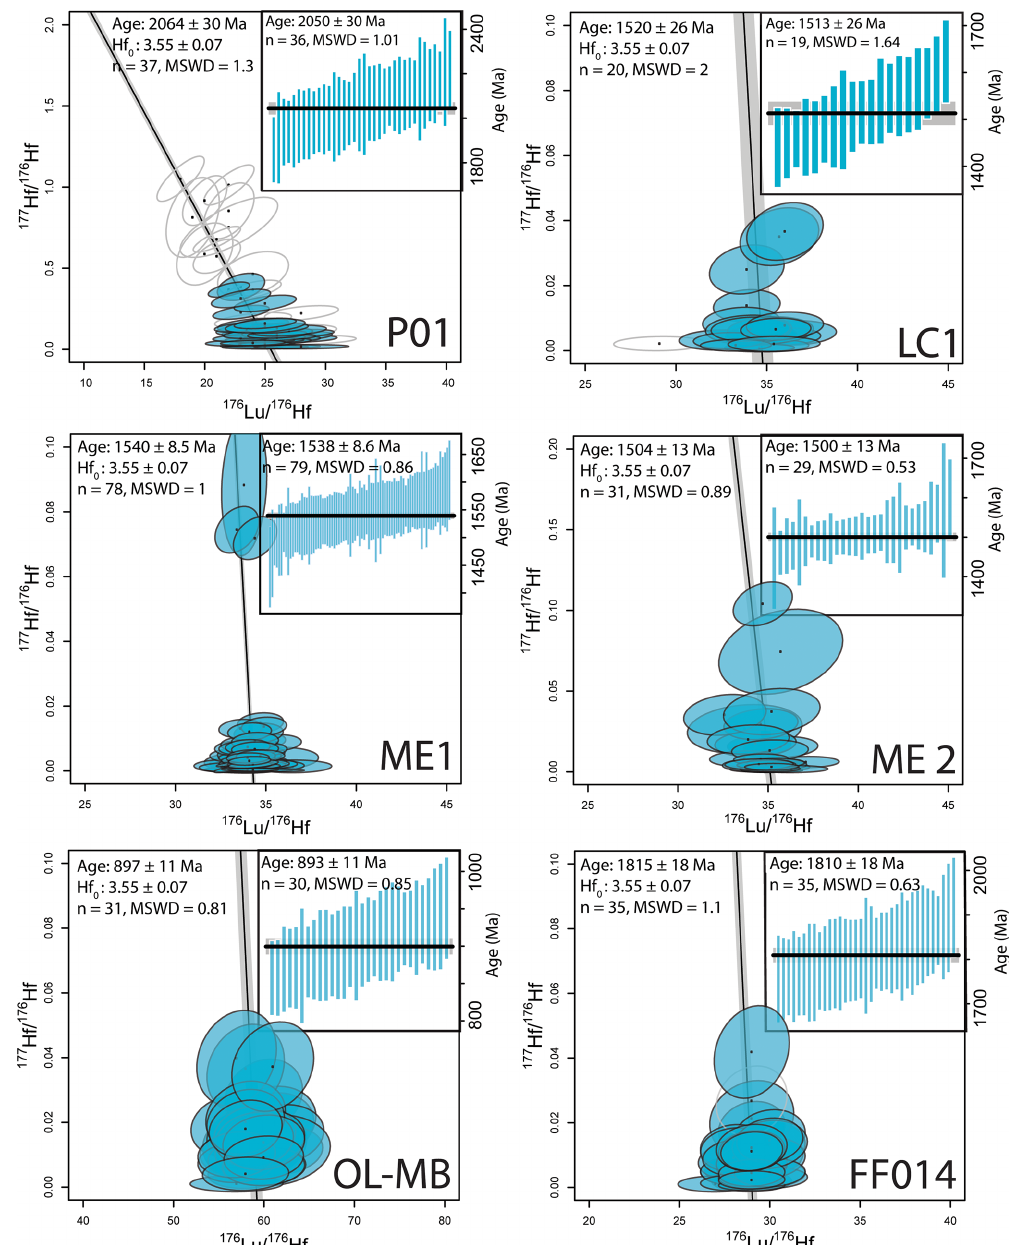
Figure 3. Anchored inverse isochron and weighted average “single-spot” ages for analysed samples, corrected for matrix-induced fraction- ation against MKED1 calcite. Isochrons have been anchored to an initial 177 Hf / 176 Hf ratio of 3.55 ± 0.07. Ellipses represent data points and 2 σ uncertainty. Weighted average ages are corrected for common-Hf where relevant (see Table 1 and text). Blue bars represent 2 σ uncertainties. Black lines represent weighted average ages, with grey boxes representing the 95% confidence interval